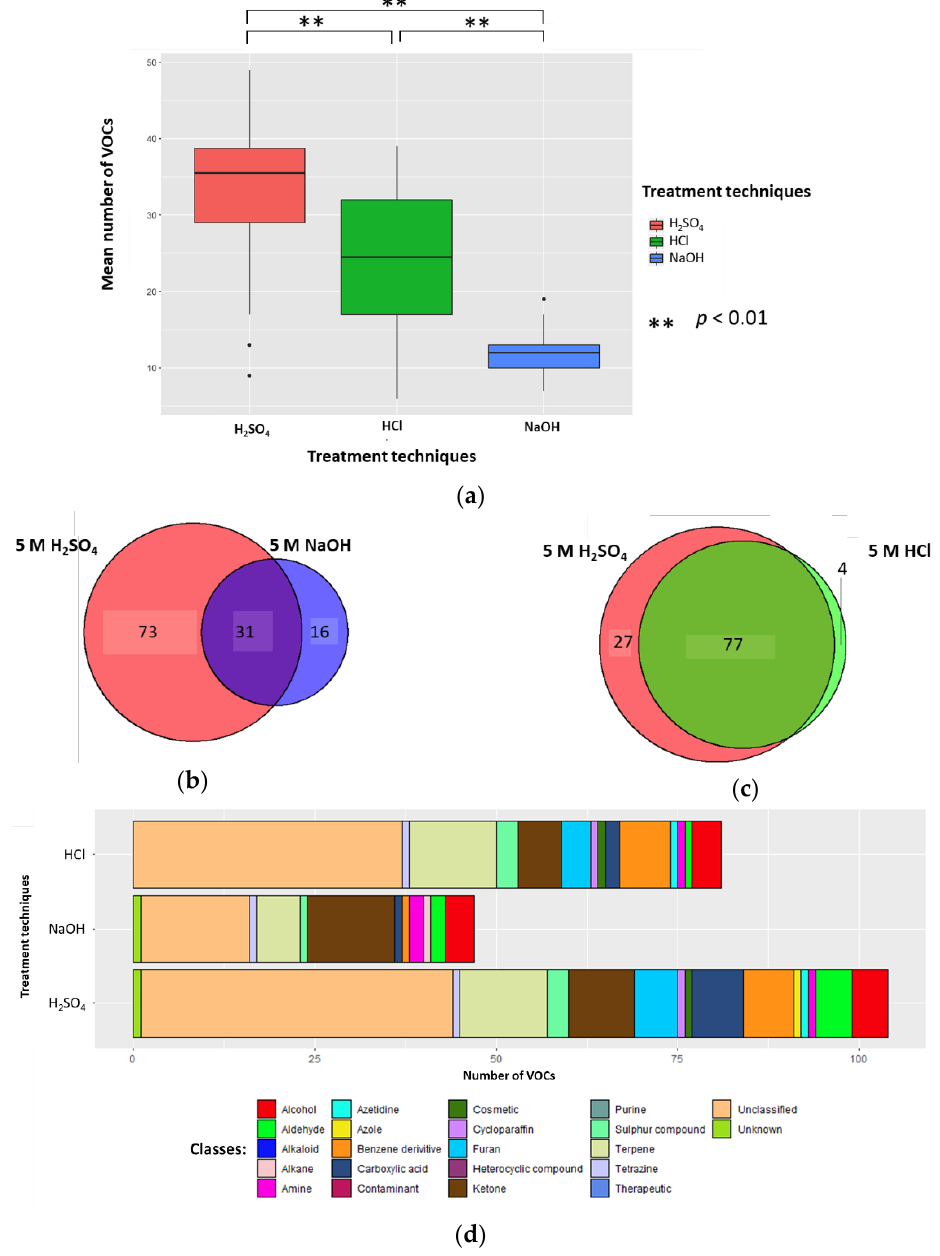
Figure 1. The urinary volatile organic compound (VOC) profiles after treatment with 5 M H 2 SO 4 (red), 5 M NaOH (blue), or 5 M HCl (green) in the samples (to generate sample solutions of 0.83 M; pH 0.075, pH 0.081, and pH 13.919, respectively) ( n = 26). ( a ) Boxplot to show the number of VOCs produced per treatment technique. ( b ) Venn to show the cumulative number of unique VOCs produced via addition of H 2 SO 4 and NaOH. ( c ) Venn to show the number of VOCs produced via addition of H 2 SO 4 and HCl. ( d ) Chemical classes of compounds produced when H 2 SO 4 , NaOH, and HCl were used as treatment techniques.